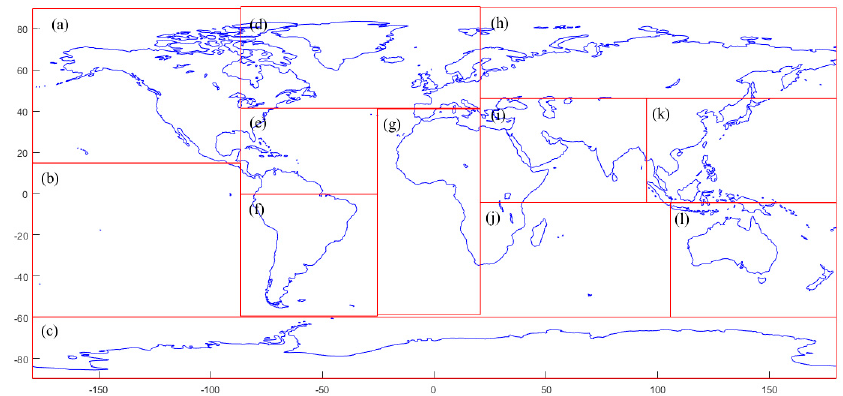
Figure 3. Division of the global earth surface domain for air traffic distribution. ( a ) North America; ( b ) Pacific Ocean; ( c ) Antarctica; ( d ) Western Europe; ( e ) Caribbean Sea; ( f ) South America; ( g ) Atlantic and Western Africa; ( h ) Russia; (i ) Middle East; ( j ) Indian Ocean; ( k ) East Asia; ( l ) Oceania.